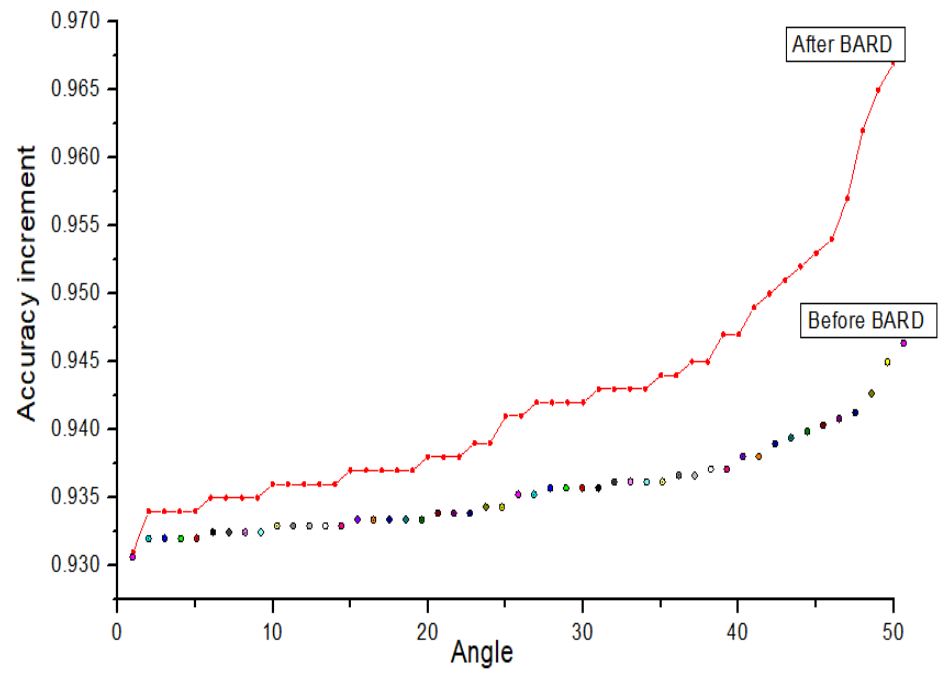
Figure 10. Accuracy incremental plot before and after introducing BARD.